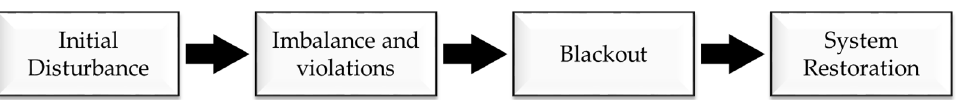
Figure 1. Typical blackout procedure.